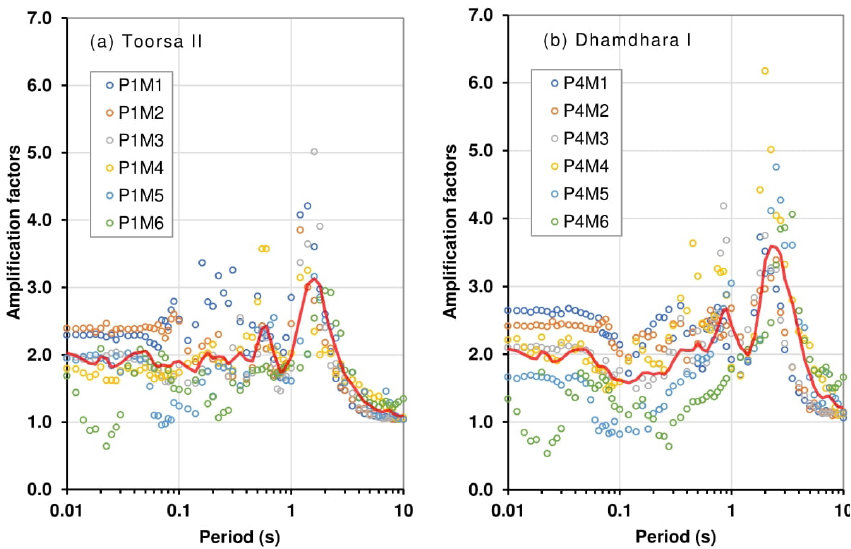
Figure 10. Examples of amplification factors for various earthquakes at (a) soil profile P1 at Toorsa II in Zone I and (b) soil profile P4 at Dhamdhara I in Zone I.